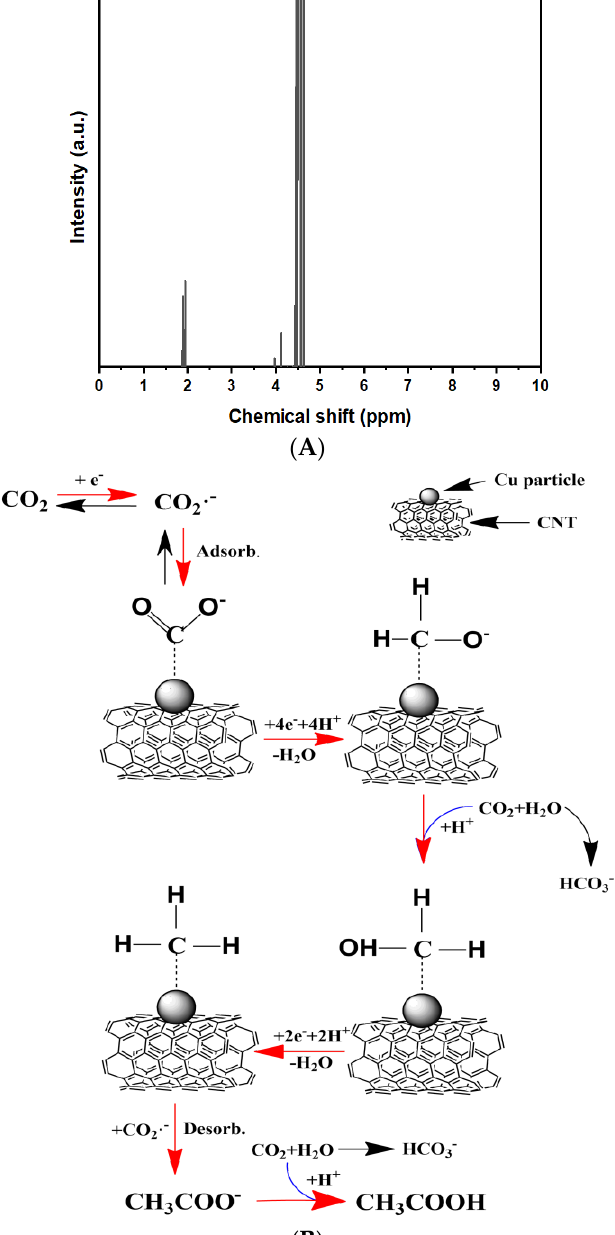
Figure 8. 1H NMR graph of the by-product electrolyte ( A ) and acetic acid by possible product pathway from CO 2 reduction ( B ).